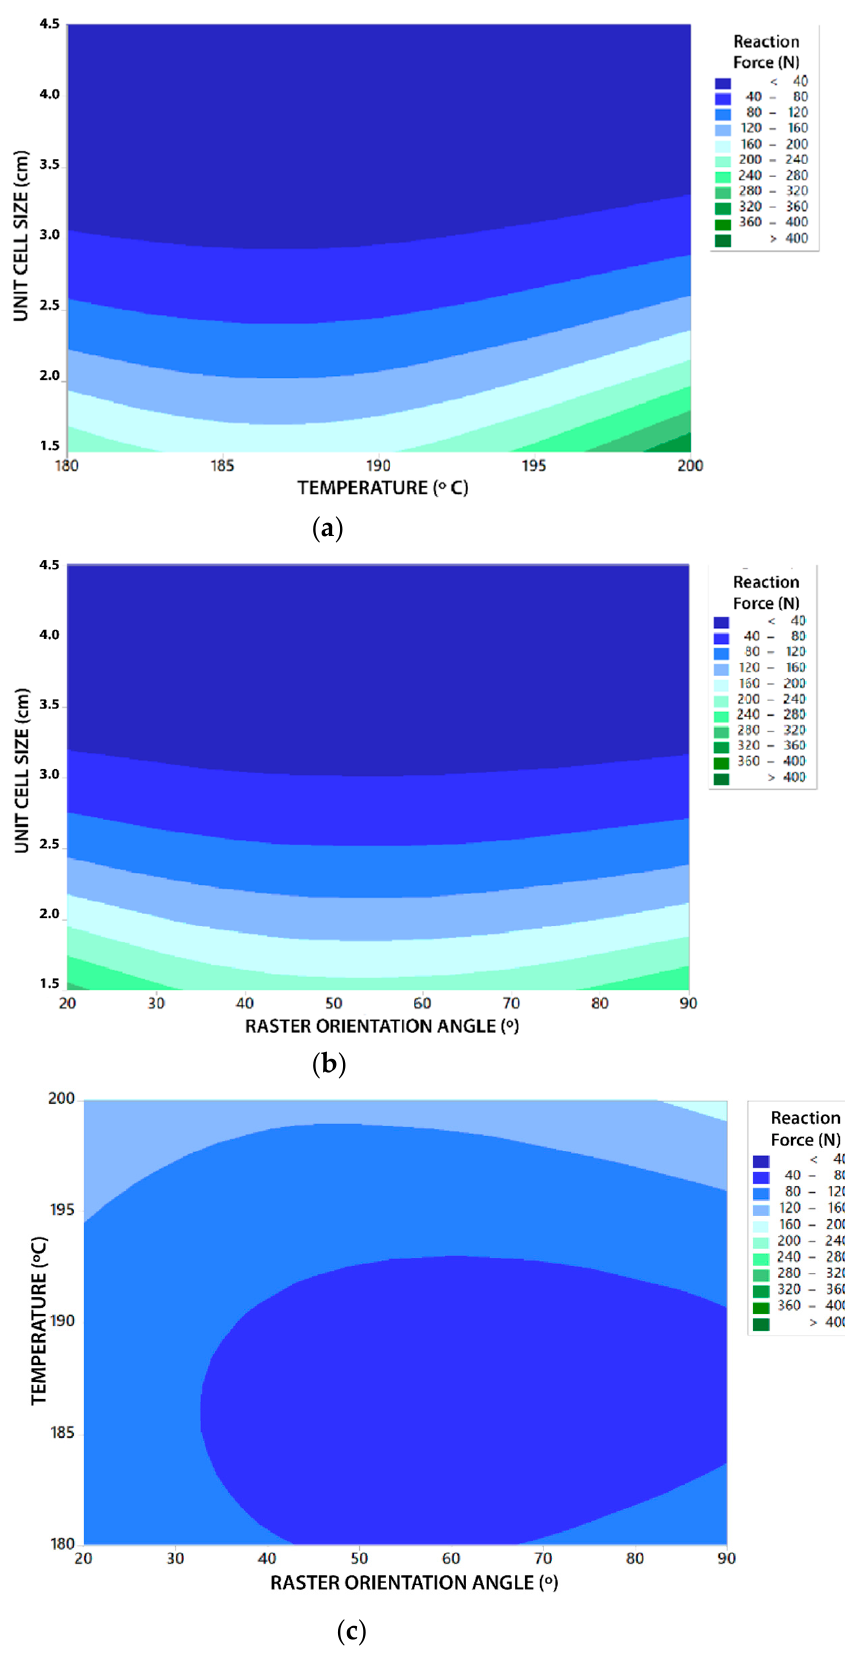
Figure C4. FBCC contour plot; ( a ) Unit cell size (U) vs. Temperature (T); ( b ) Unit cell size (U) vs. Raster Orientation Angle (R); ( c ) Temperature (T) vs. Raster Orientation Angle (R).